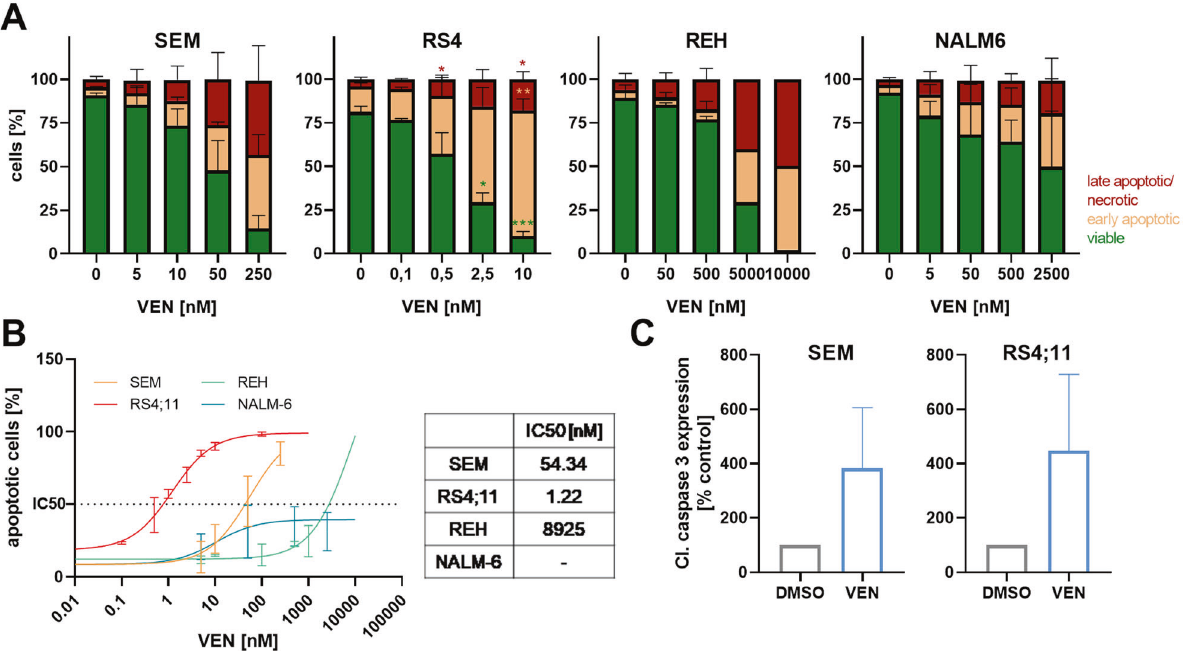
Fig. 2 In fl uence of VEN on apoptosis induction. A Cells were incubated with increasing concentrations of VEN for 72 h before staining with Annexin V-FITC and propidium iodide and subsequent fl ow cytometry. Mean ± SD of 1 – 4 biological replicates; two-way ANOVA with post hoc Dunnett ’ s multiple comparisons test. Asterisks indicate signi fi cance compared to the respective DMSO control. B Dose-response curves (nonlinear regression, curve fi t) of cell lines incubated with increasing concentrations of VEN for 72 h. Apoptotic cells were assessed by AnnV/ PI staining and fl ow cytometry and early and late apoptotic/necrotic) cells were added to calculate the amount of apoptotic cells. Mean ± SD of 1 – 4 biological replicates. C Protein expression of cleaved caspase-3 was analyzed by intracellular fl ow cytometry after 48 h incubation with 2.5 nM (RS4;11) or 10 nM (SEM) VEN or DMSO (control). Mean ± SD of three biological replicates; paired t